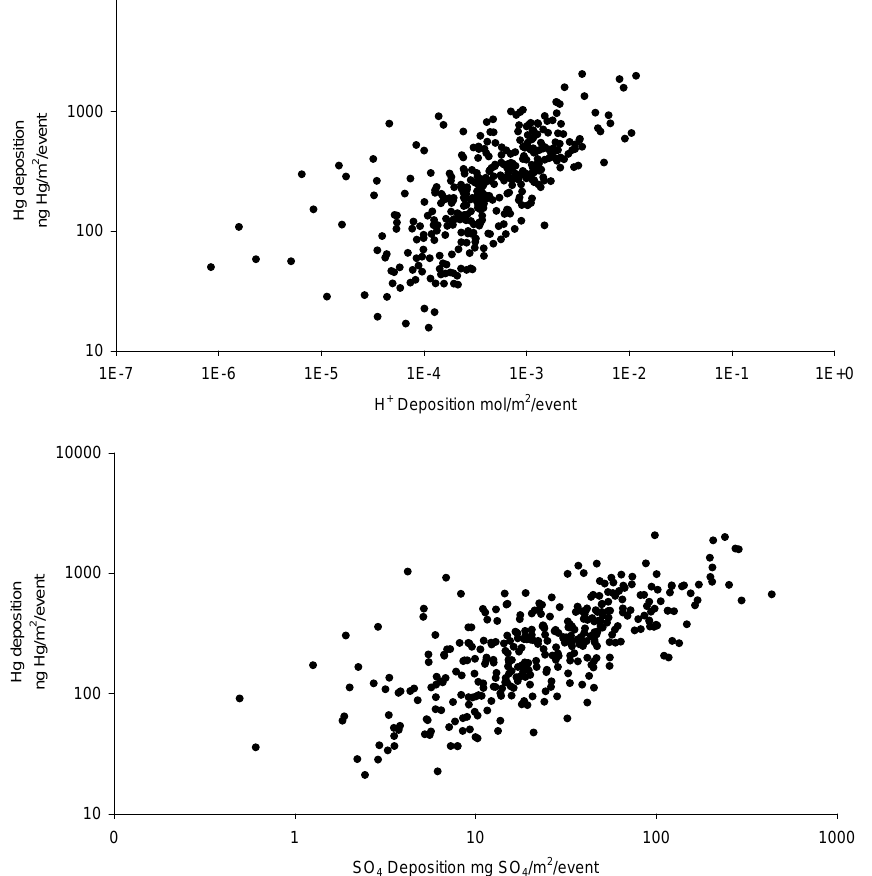
Fig. 7. Plot of Hg deposition (ng/m 2 /event) versus H + deposition (mole/m 2 / /event) (top panel) and Hg (ng/m 2 /event) versus sulfate deposi- tion (mg SO 4 /m 2 /event) (bottom